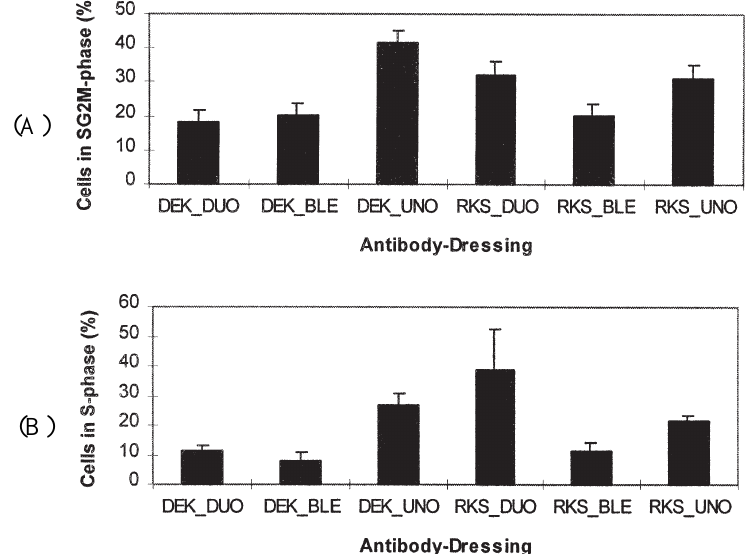
Fig. 3. (A) Percentages of cells in SG 2 M-phase in the keratin 10-negative compartment 48 h following tape stripping; unoc- cluded (UNO) or after occlusion with Duoderm (DUO) or Blenderm (BLE). (B) Percentages of cells in S-phase in the keratin 10-negative compartment 48 h following tape stripping; unoccluded (UNO) or after occlusion with Duoderm (DUO) or Blen- derm